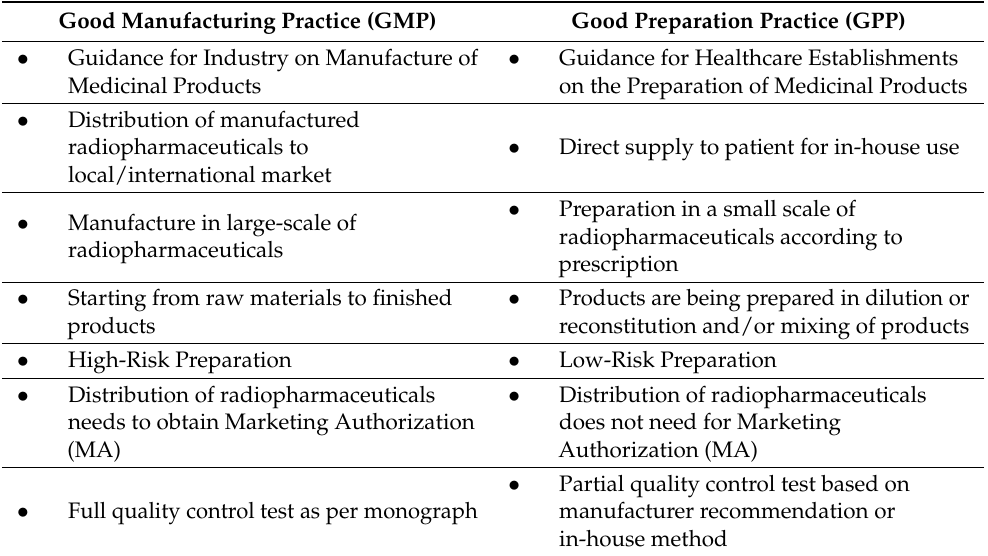
Table 11. Main differences between Good Manufacturing Practices (GMP) and Good Preparation Practices